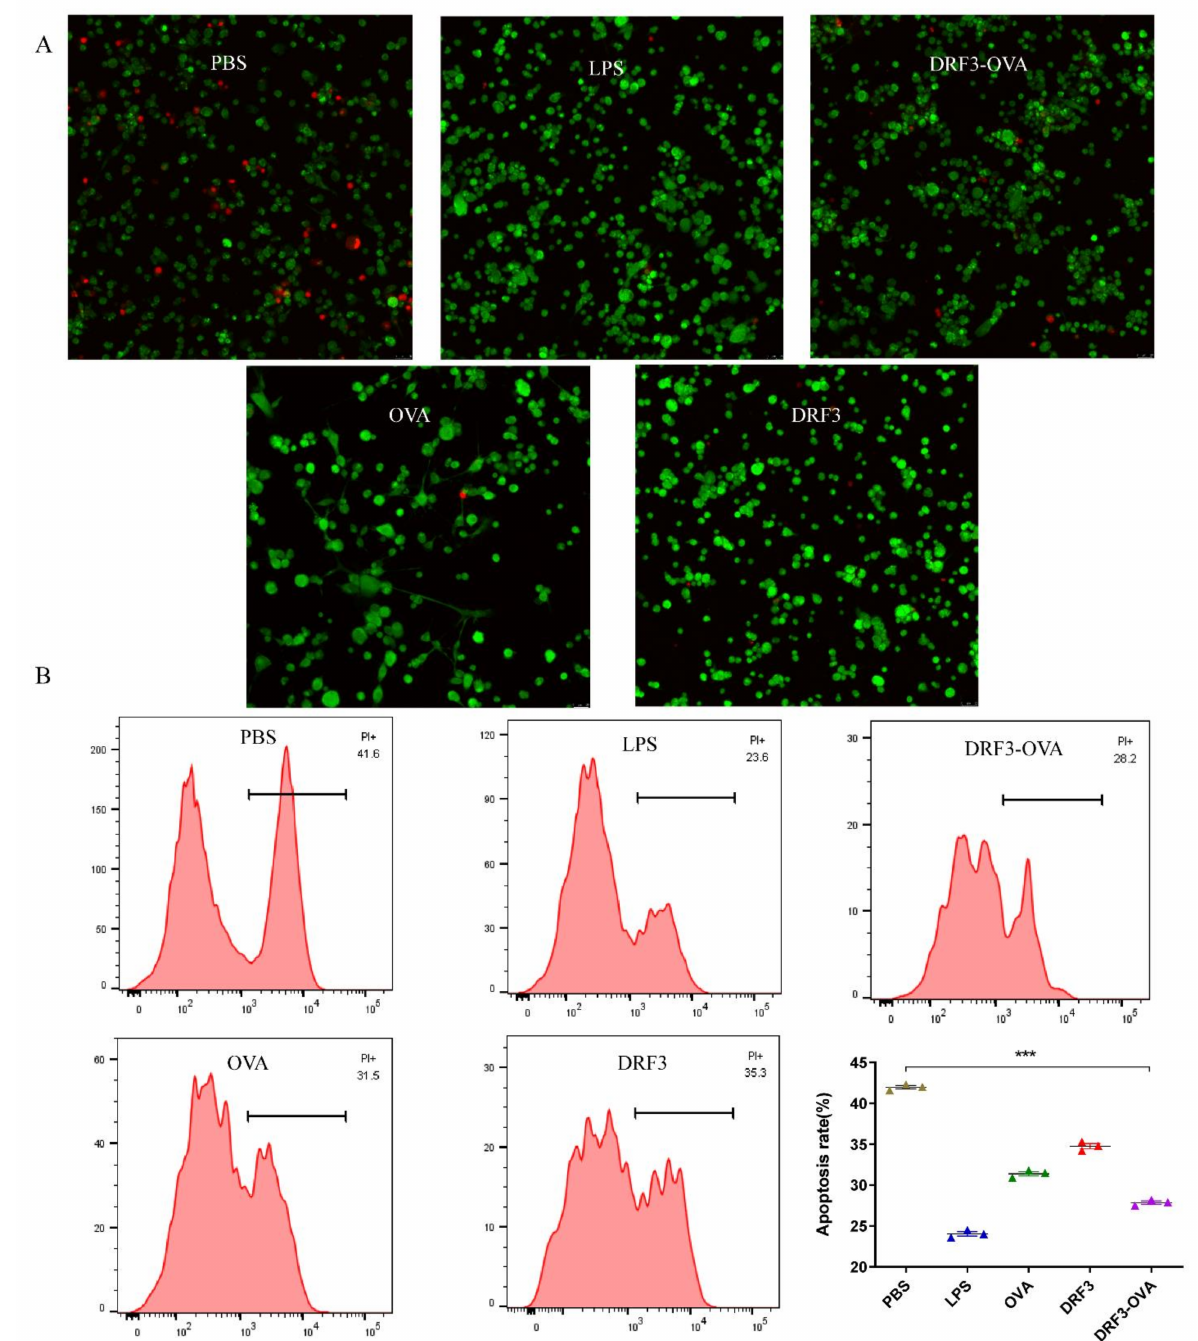
Figure 10. Biocompatibility detection of DRF3. ( A ) all groups were observed by confocal microscope after co-culture with DC; ( B ) the apoptosis rate of DC in each group was measured by flow cytometry (The results were repeated three times, shown as mean ± SEM; *** means significant differences p <